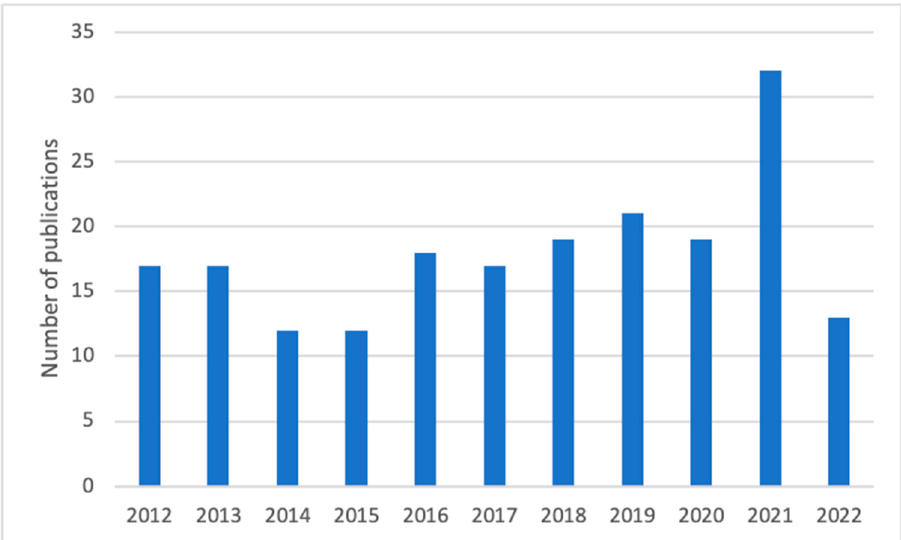
Figure 1. Research tendency containing the terms “ Vaccinium myrtillus ” and “leaves” in publications from 2012 to 31 June 2022 (indexed by the Web of Science Core Collection).